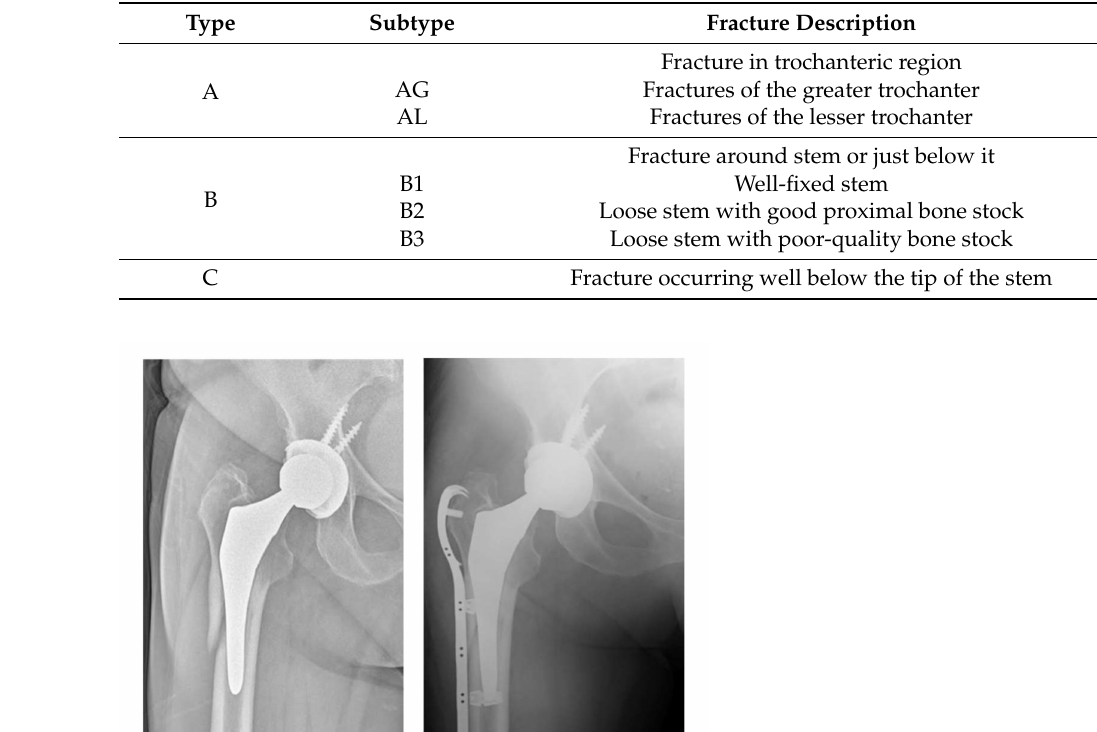
Table 2. Vancouver classification.